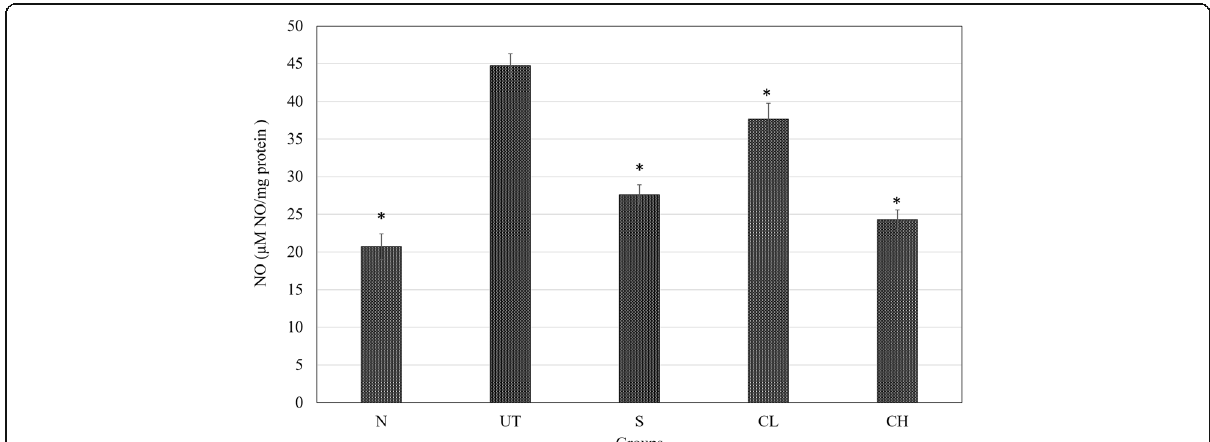
Fig. 5 Effect of coconut water vinegar on liver nitric oxide (NO) level in the liver of acetaminophen challenged mice. All values are expressed as means mean ± SD of 6 mice in each group. * P < 0.01 as compared with the untreated control group. N: normal healthy control; UT: untreated acetaminophen-induced control; S: acetaminophen-induced treated with 50 mg/kg silybin; CL: acetaminophen-induced treated with 0.08 ml/kg